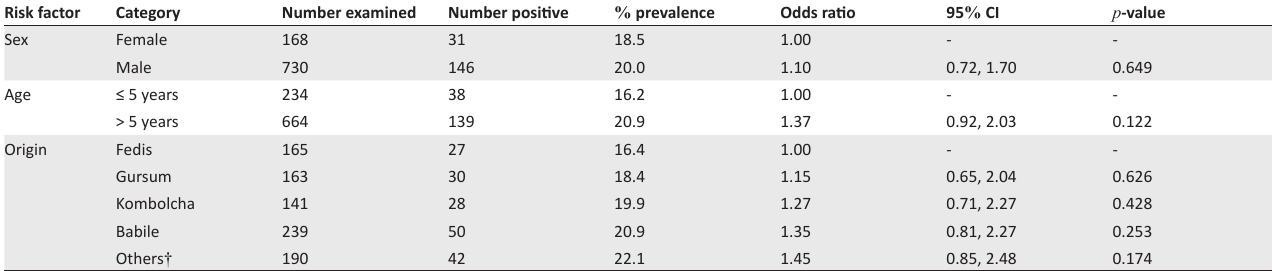
TABLE 2: Occurrence of Taenia saginata cysts with regard to sex, age and origin of cattle slaughtered. Risk factor